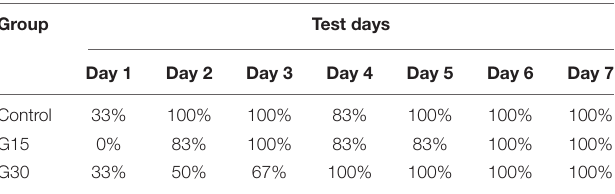
TABLE 1 | Percentage of animals that completed the eight-arm radial maze task consuming all the food present in the apparatus before 10 min in each of the 7-day